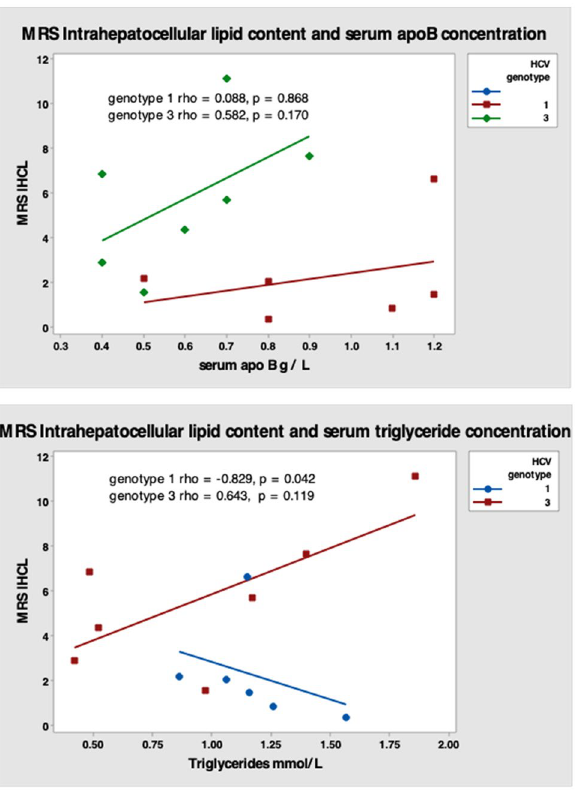
Figure 3. Correlation between intra-hepatocellular lipid content (steatosis) and fasting serum apoB concentration and triglycerides in HCV genotypes 1 (N = 6) and 3 (N = 7).